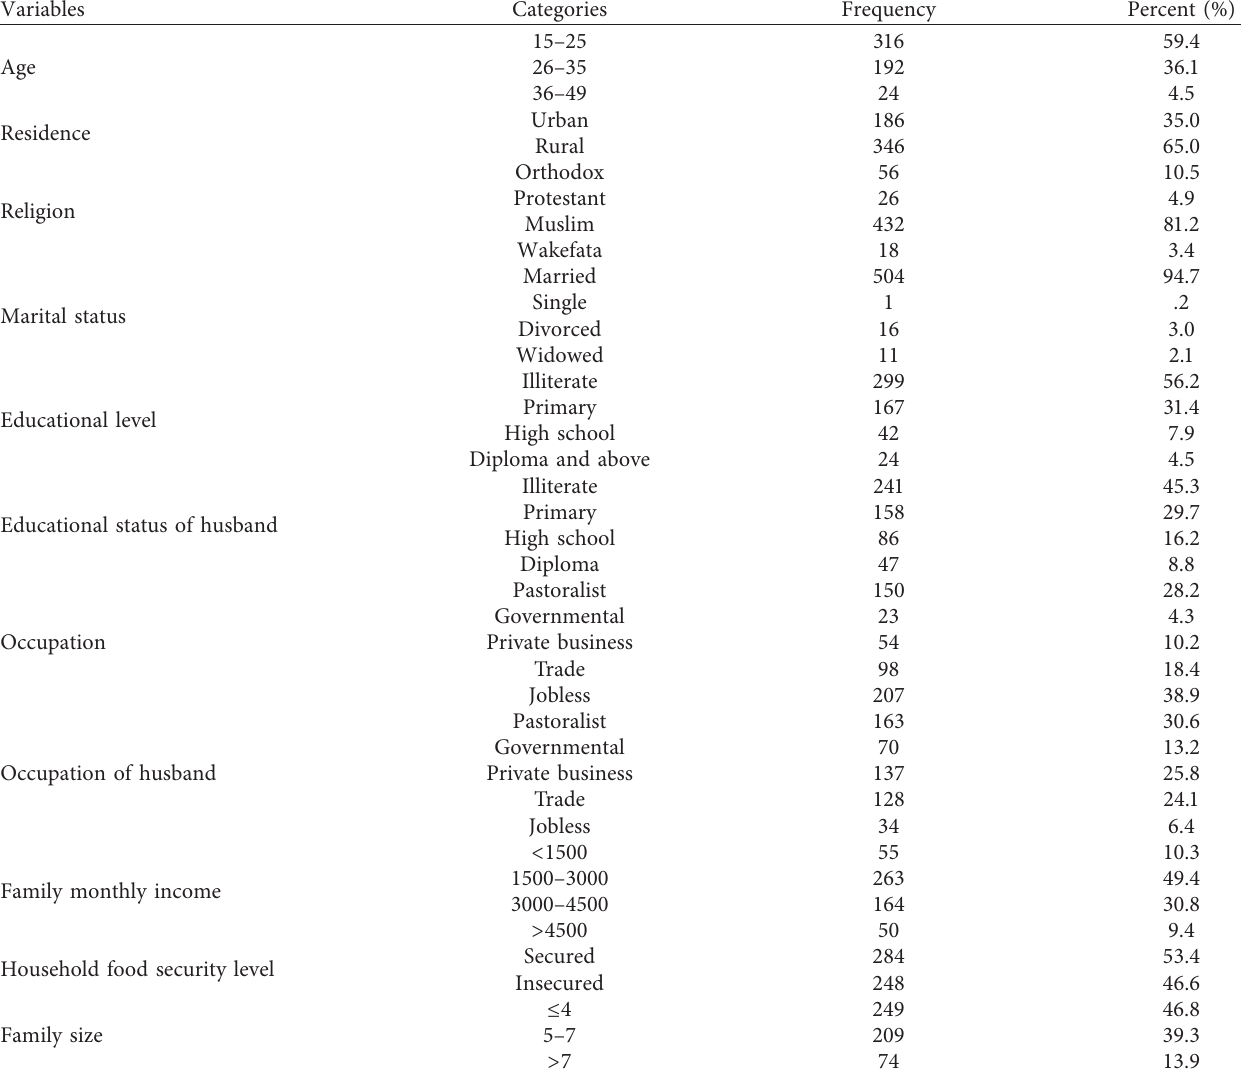
Table 1: Socioeconomic and demographic characteristics of lactating women ( N � 532) in Moyale District, Borana, Southern Ethiopia, 2018.